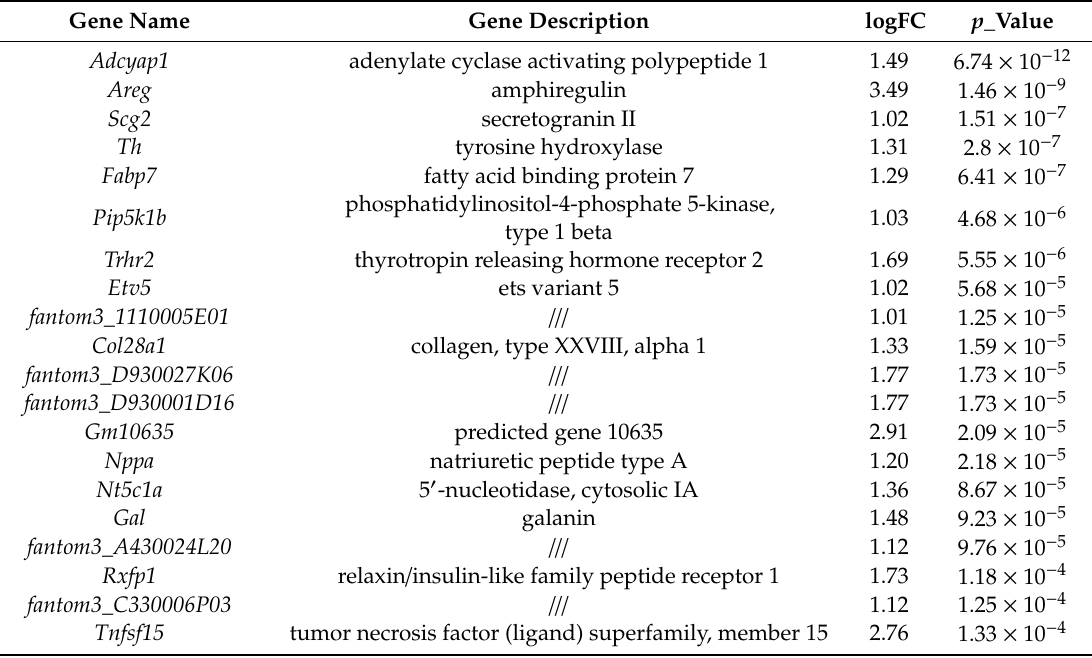
Table 2. 20 genes upregulated in Se-Met-treated 3×Tg-AD mice versus 3×Tg-AD mice.